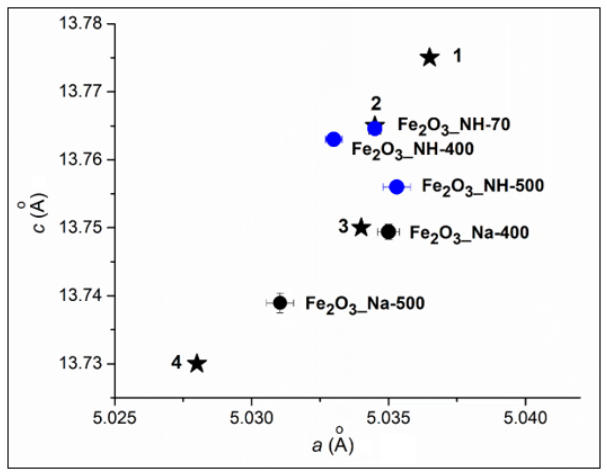
Figure 2. The lattice parameters c ‐ a of hydrohematites in nanoparticles prepared using NaOH and NH 4 OH precipitators and calcination at 400 and 500 °C between others parameters of hydrohematies: ★ 1—PDF No. 01 ‐ 073 ‐ 8432 (Fe 1.85 (OH) 0.66 O 2.34 ), ★ 2—PDF No. 01 ‐ 073 ‐ 8433 (Fe 1.85 (OH) 0.45 O 2.55 ), ★ 3—PDF No. 01 ‐ 076 ‐ 0182 (Fe 1.83 (OH) 0.50 O 2.50 ) and hematite: ★ 4—PDF No. 00 ‐ 001 ‐ 1053 (Fe 2 O 3 ).